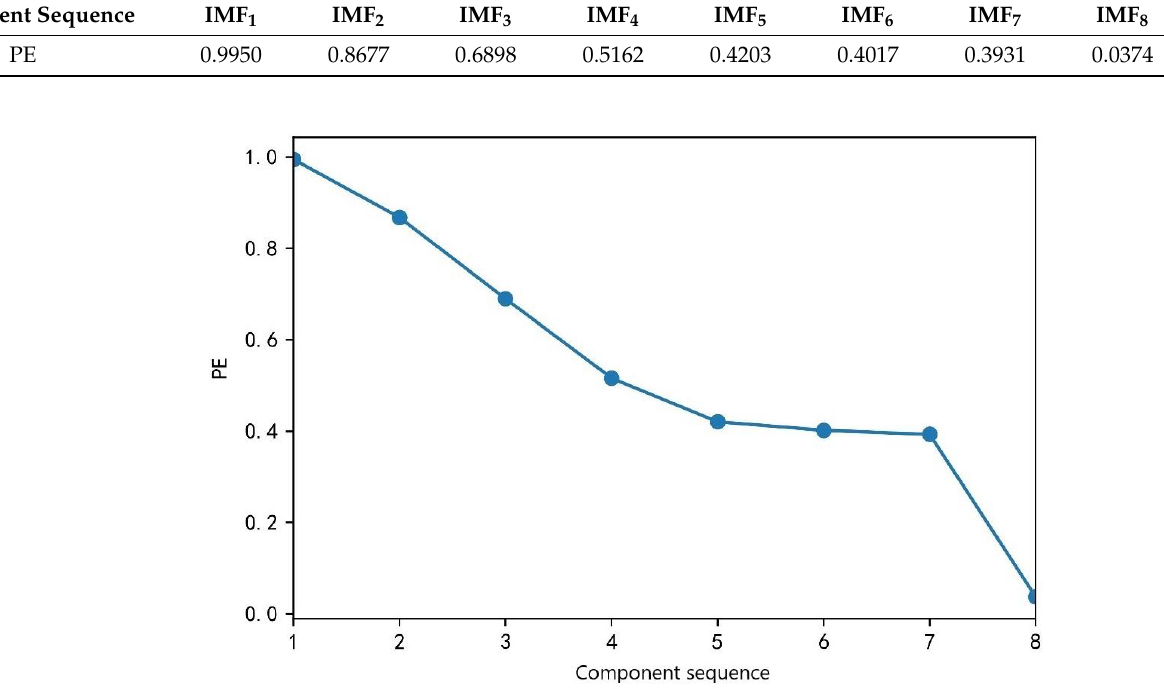
Figure 8. Permutation of entropy values by IMF sequence.